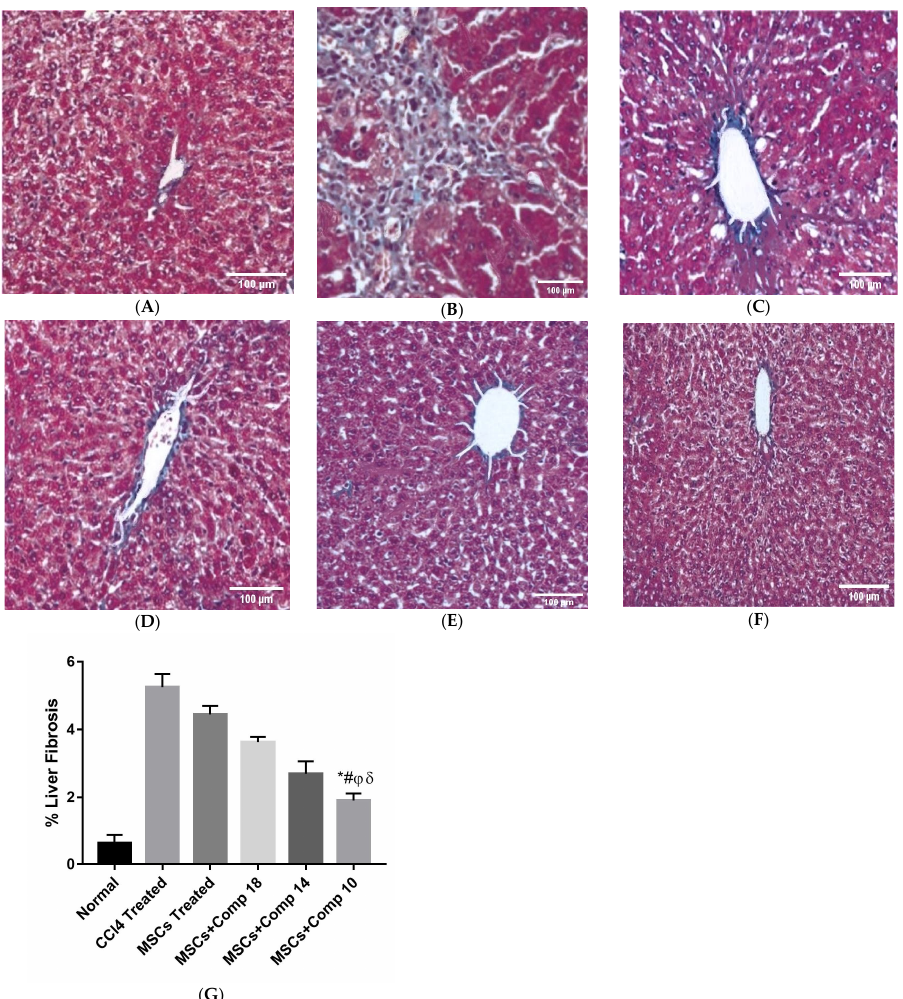
Figure 10. Masson trichome ‐ staining for collagen (blue) in liver tissue after MSCs + compounds treatment: ( A) normal; ( B ) CCl4 ‐ treated; ( C ) MSCs ‐ treated; (D ) MSCs + compound ( 18 ); ( E ) MSCs + compound ( 14 ); ( F ) MSCs + compound ( 10 ); ( G ) bar graph showing % of liver fibrosis in different groups (100 × ; scale bar: 100 µ M). Bars and different symbols show significance with each other at p < 0.05. Collagen amount greatly decreased in the MSCs + compound ( 10 )-treated rat experimental model compared to all other groups, as shown by bars with symbols. * p < 0.05 for MSCs + Comp10 vs. CCl4; # p < 0.05 for MSCs+Comp10 vs. MSCs; ϕ p < 0.05 for MSCs + Comp10 vs. MSCs + Comp18; δ p < 0.05 for MSCs + Comp10 vs. MSCs +